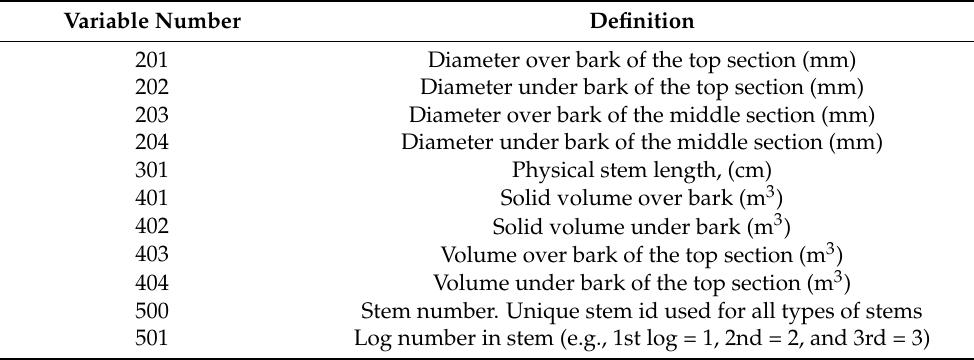
Table 1. Description of the forest inventory data in pri file (identification number of variables and definition).